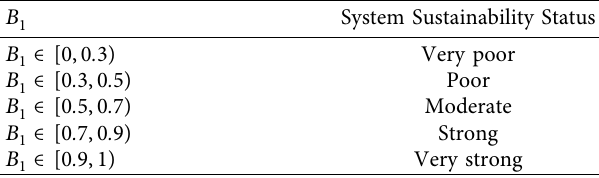
Table 1: Degree grading on the interval [0, 1]. B